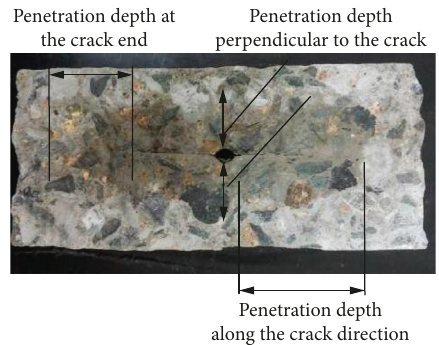
Figure 5: Penetration figure after concrete block splitting.